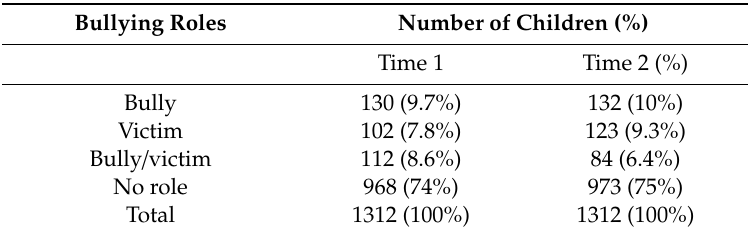
Table 3. Number (percentage) of children in each bullying role.